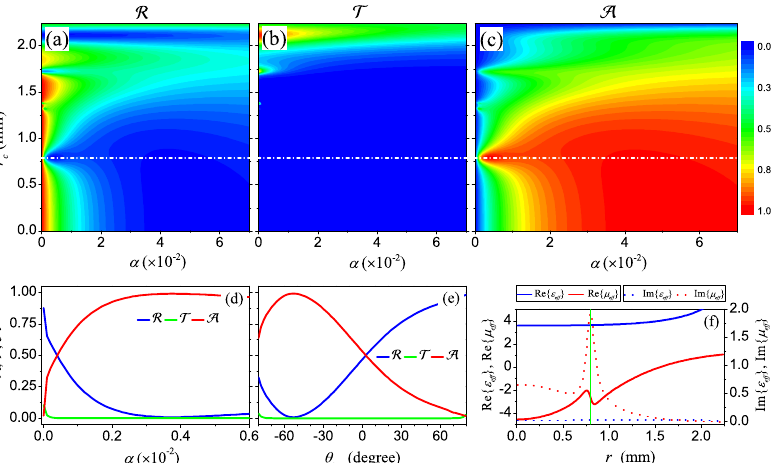
Figure 5. R ( a ), T ( b ), and A ( c ) are plotted as the functions of damping factor α and the inner radius r c of dielectric core for the MM slab of type III at a fixed incident angle θ inc = − 55 ◦ . The spectra are plotted as the functions of the damping factor α ( d ) and the incident angle θ inc ( e ) for the optimized core radius r c = 0.8 mm. ( f ) The effective permittivity ε ef f and effective permeability µ ef f are plotted as the functions of core radius r c at a fixed damping factor α = 3.5 × 10 − 3 . The BMF is H 0 = 600 Oe, the permittivity of dielectric core ε c = 15 for DCL ferrite rod, the working frequency is f = 4 GHz and the other parameters are the same as those in Figure 2.